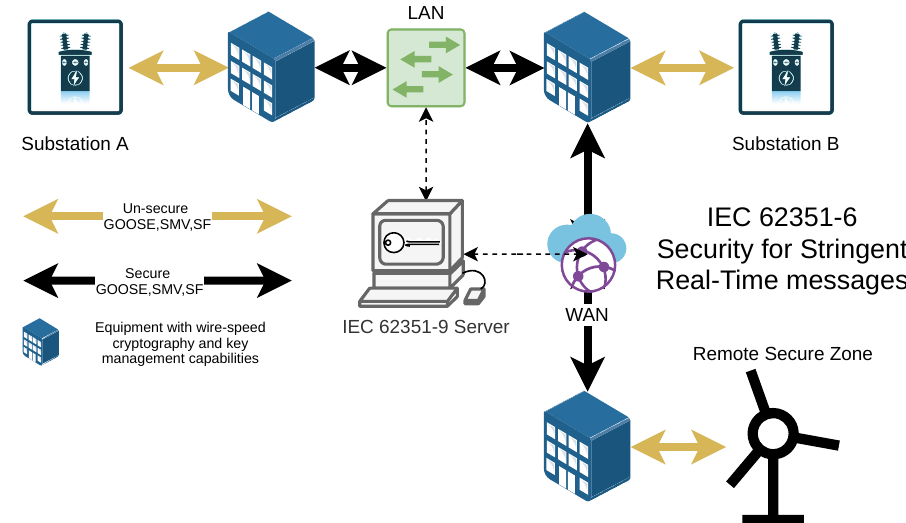
Figure 4. Schematic setup for secure real-time GOOSE and SMV